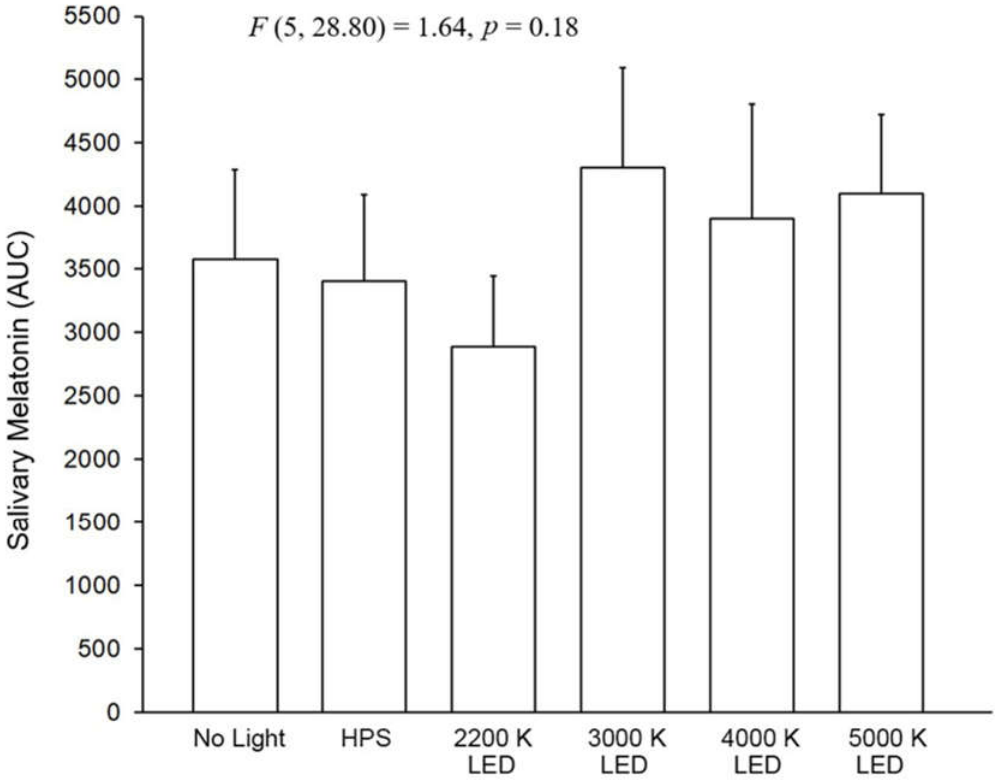
Figure 10. The bars shown above represent the AUC mean salivary melatonin levels in the pedestrian